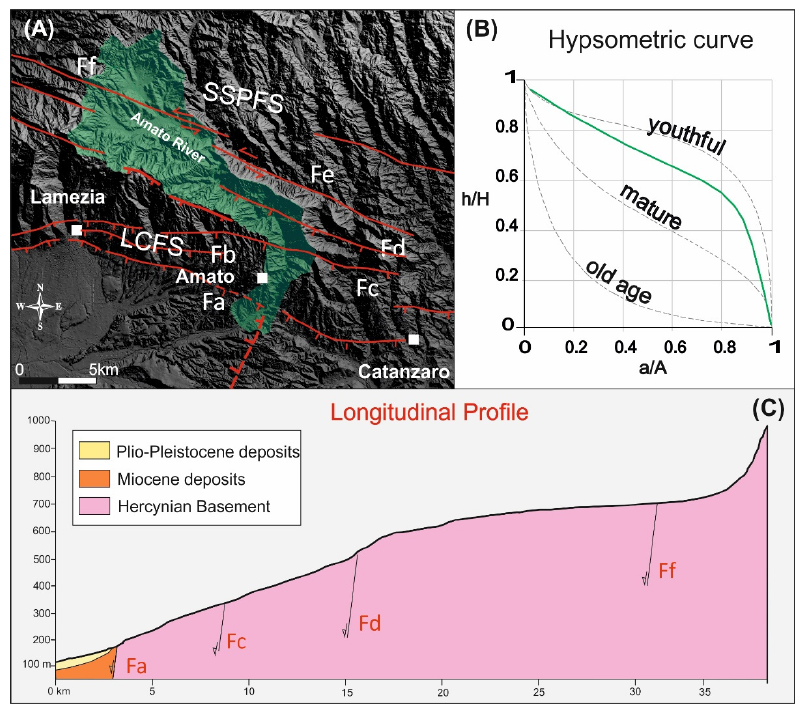
Figure 7. ( A ) DTM hillshade showing the Am4 sub-basin and the faults crossing the area. ( B ) Hypsometric curve of the Am4 sub-basin. ( C ) Longitudinal profile of the main river trunk of the Am4 sub-basin and faults.